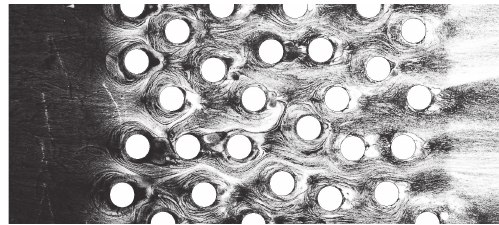
Figure 10: Surface flow visualization of G 2.6.